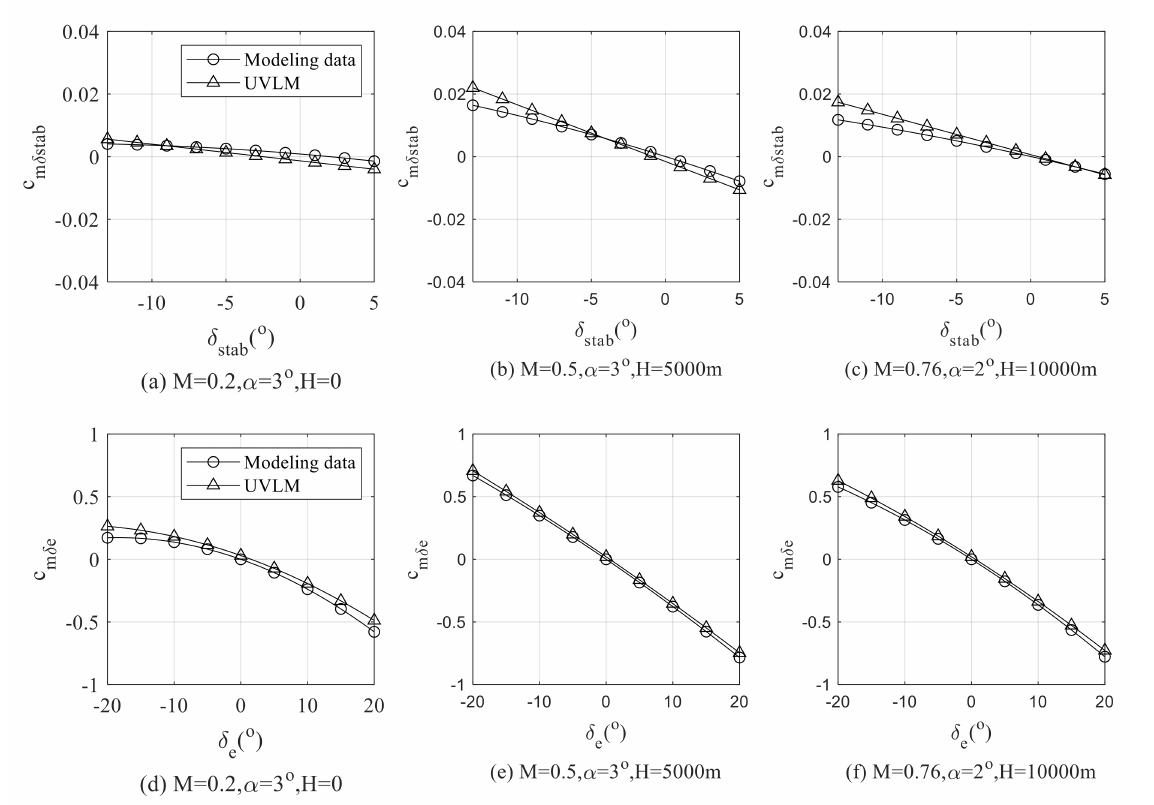
Figure 8. Comparison of pitching moment